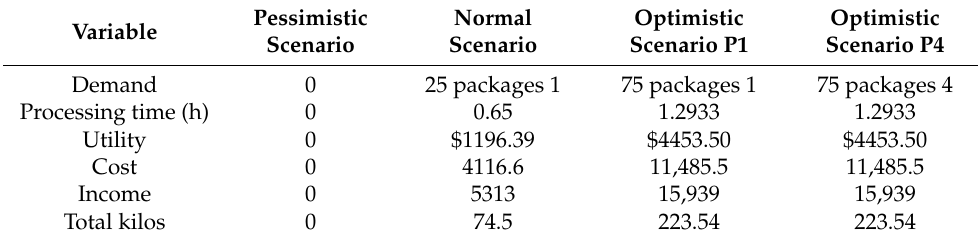
Table 1. Comparison of scenarios.